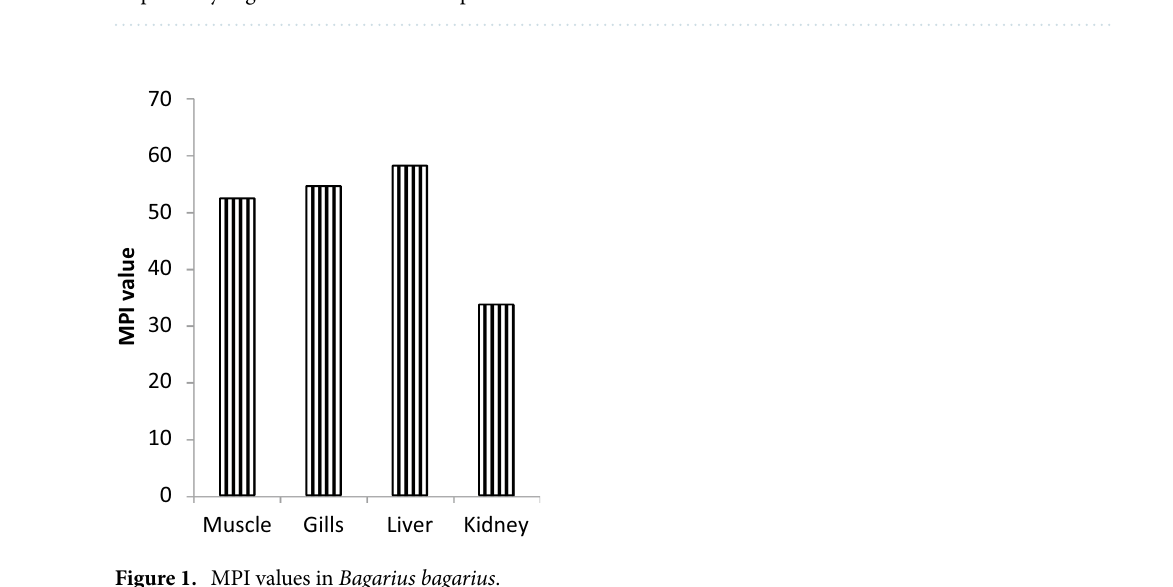
Table 3. Heavy metal concentrations in Bagarius bagarius tissues (mg/kg.dw). All values are presented as mean ± SEM (n = 15). Superscripts and subscripts represents significant differences along the row and column respectively. Significance was tested at p < 0.05.